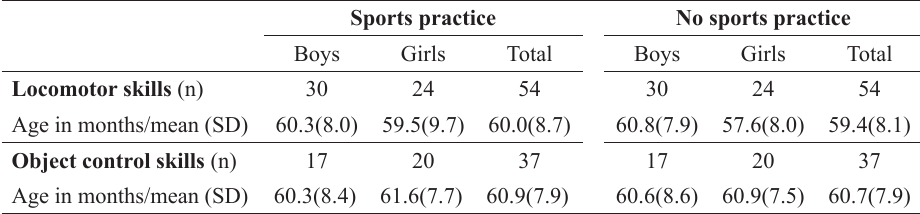
1. Sample size ( n ), mean of age and standard deviation (SD) in months of the preschoolers boys and girls who performed locomotor and object control subtests in the sports practice (SP) and no sports practice (NSP) groups.